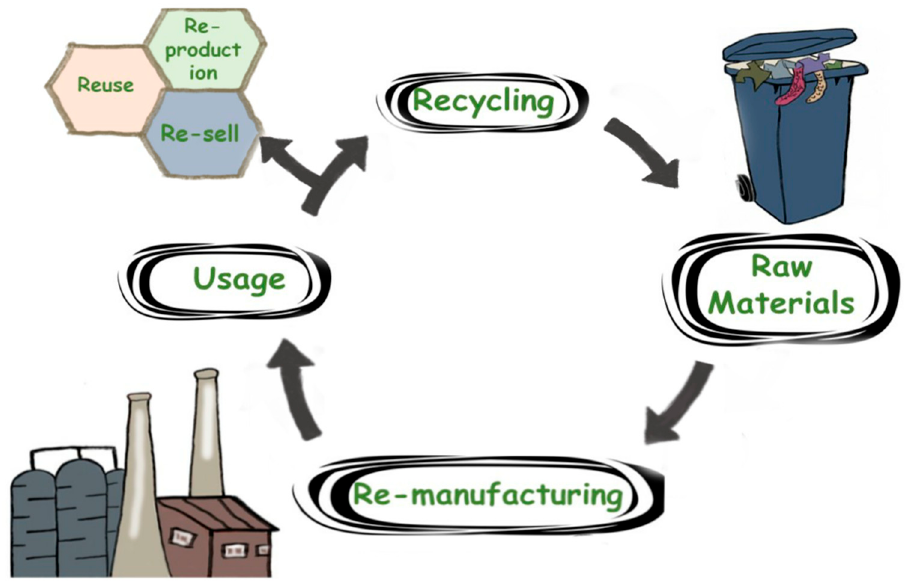
Figure 1. The critical point of CE.